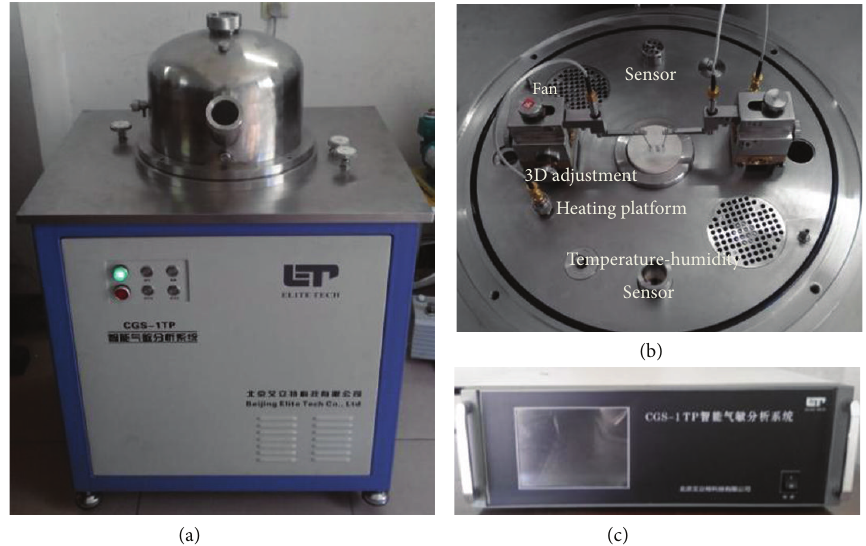
Figure 2: (a) The CGS-1TP gas sensing analysis system. (b) A photograph of the operating platform. (c) The control chamber of CGS-1TP.